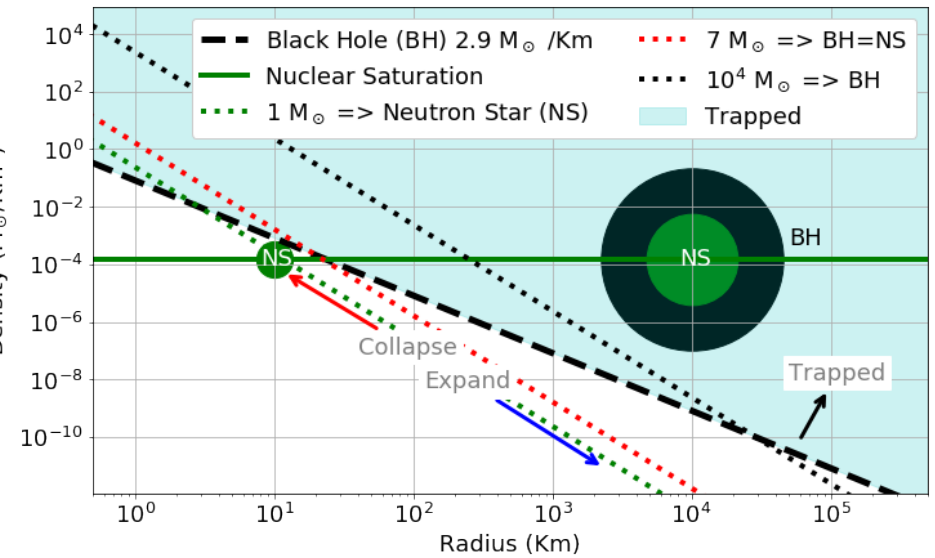
Figure 1. Illustration of the collapse of one solar mass (1 M (cid:12) , green dotted line) Neutron Star (NS). As the NS collapses the radius R decreases and the density increases as R − 3 . The collapse stops (bounce back or explodes as a supernova) when the density reaches nuclear saturation ρ ns (green horizontal line). For masses larger that 7 M (cid:12) (red dotted line) the cold cloud collapses first into a BH and matter gets trapped inside the event horizon r S (black dashed line R − 2 ). A NS could collapse inside a larger BH, but it can not escape r S .